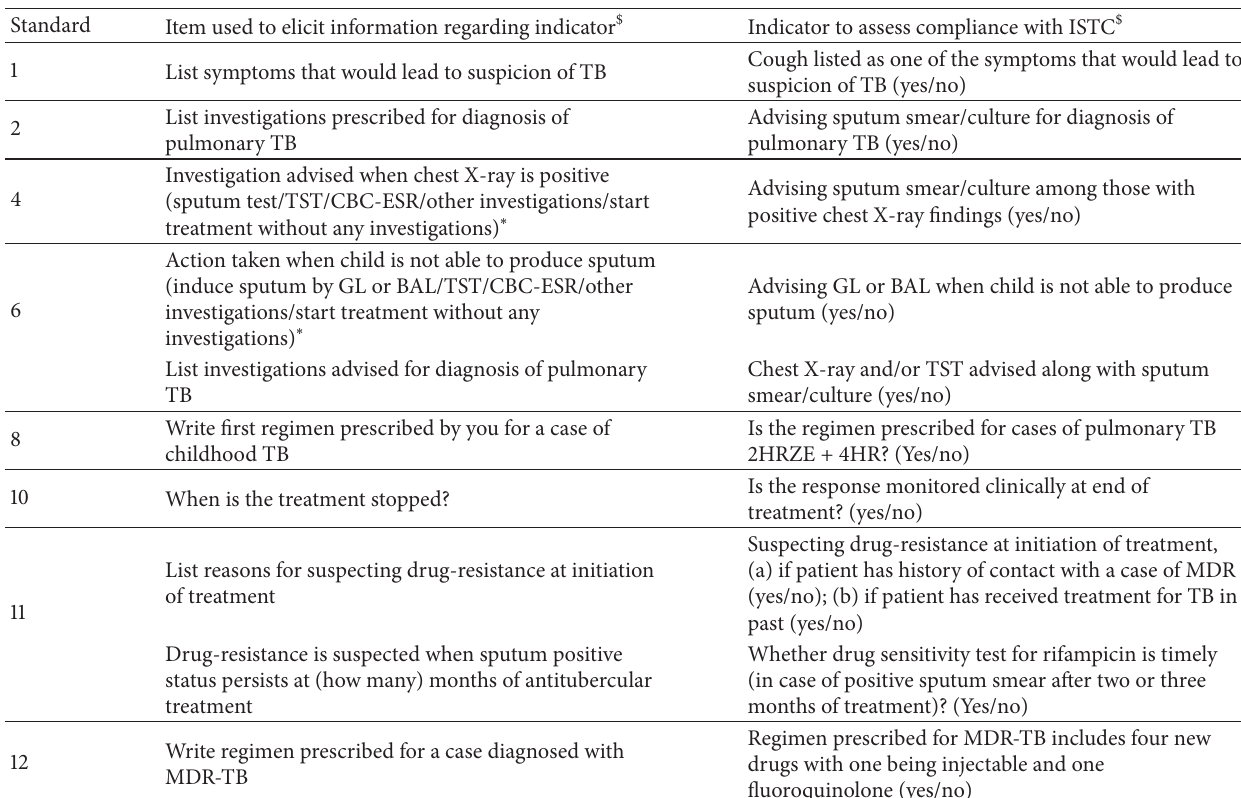
Table 1: Indicators and items developed for assessing compliance of paediatricians with International Standards of Tuberculosis Care (ISTC)